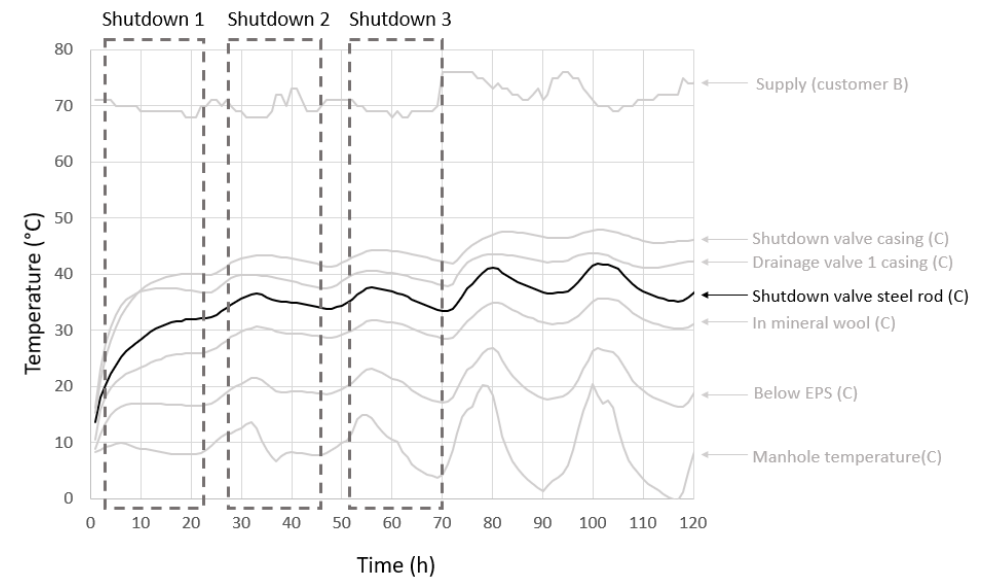
Figure 5. Measurement results from thermocouples, with a focus on the shutdown